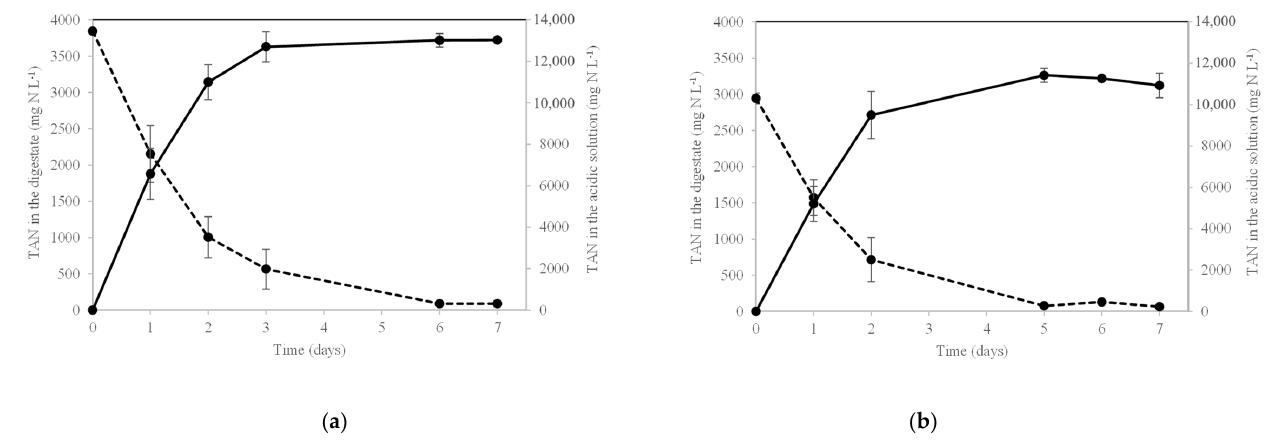
Figure 5. Evolution of TAN concentration in the digestates in D-R1 ( a ), and D-R2 ( b ) (discontinuous line), and TAN concentration in the acidic solutions for D-R1 ( a ) and D-R2 ( b ) (continuous line). Table 3. Mass balances of the recovery of TAN from the digestates D-R1 and